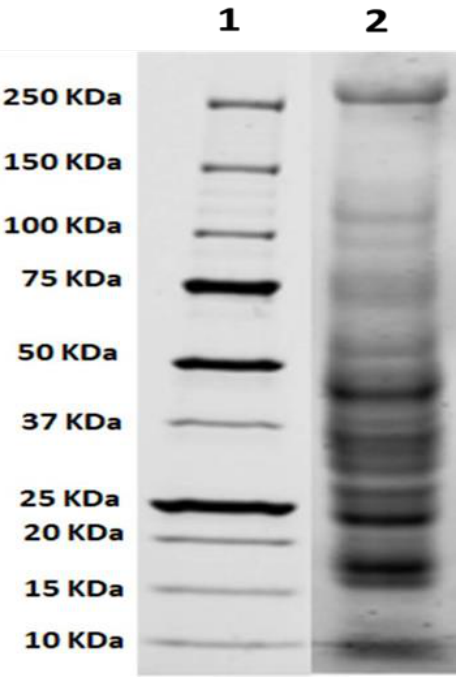
Figure 1. SDS-PAGE protein profile of R. nomadica venom. Lane 1: standard marker, Lane 2: protein extracts from the crude venom.